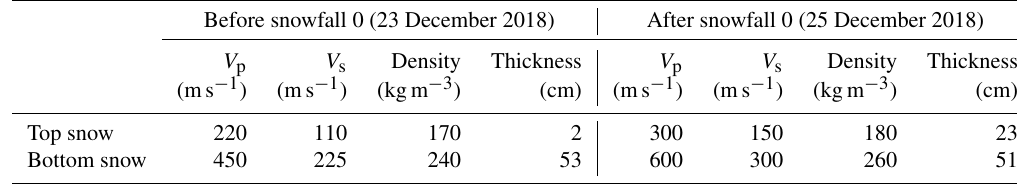
Table 2. Values of the snow model for snowfall 0 (SF0).